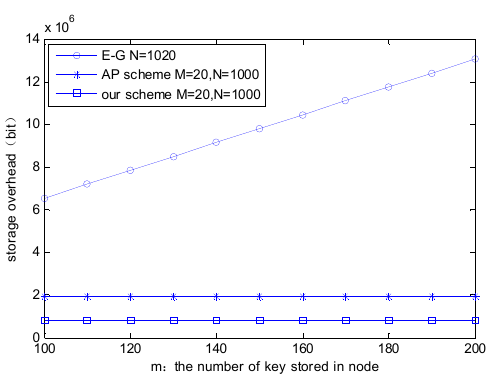
Figure 7. The comparison of node’s storage overhead among E-G, AP, and the proposed scheme after the session key establishment.